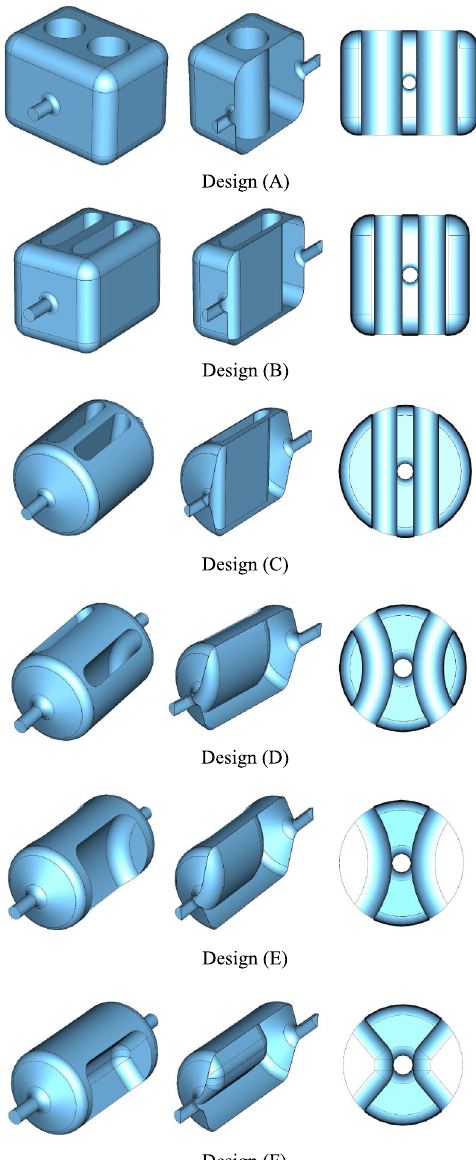
FIG. 7. Longitudinal electric field component at an offset of 1, 5, and 10 mm at an energy content of 1 J in a 499 MHz parallel- bar cavity shown in Fig. 3.